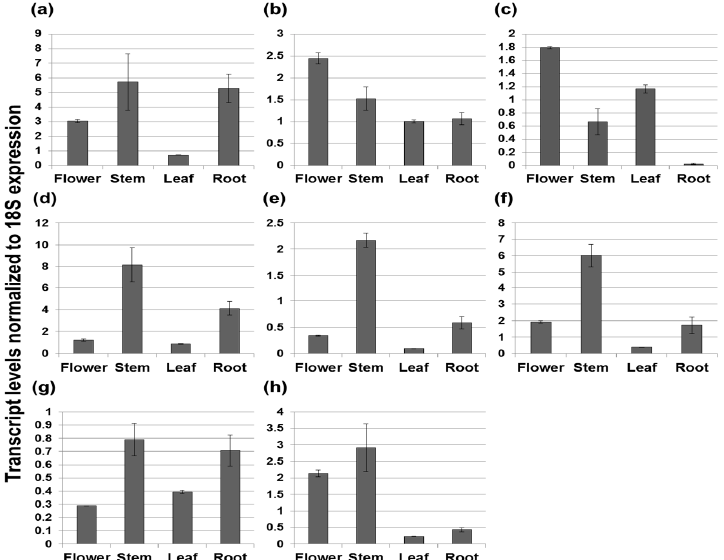
Figure 2. Transcript levels of MVA biosynthetic genes in different organs of V. fauriei ( Vf ). Genes encode